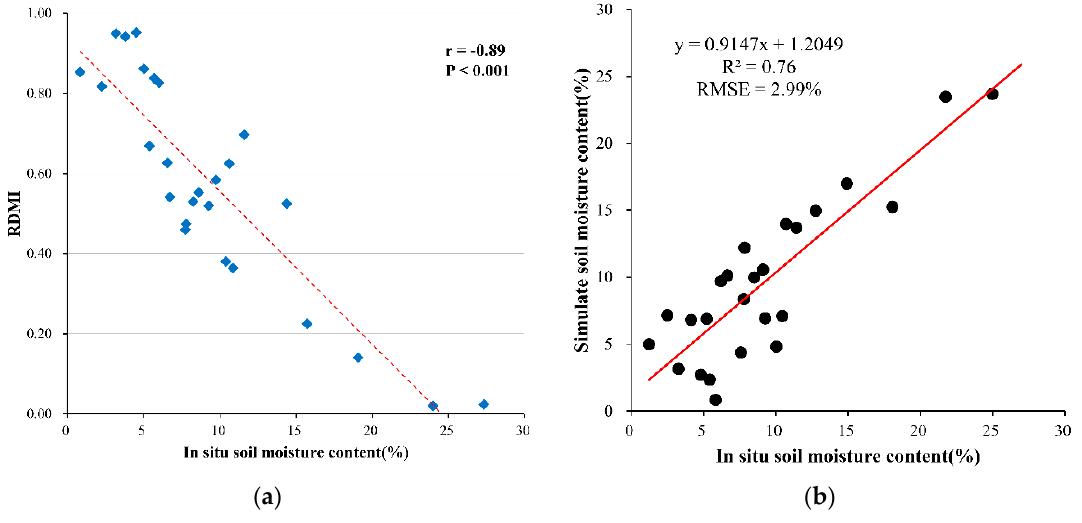
Figure 11. ( a ) The relationship between the RDMI and in situ soil moisture (n = 26). ( b ) The correlation between the estimated soil moisture content and the in situ soil moisture content.